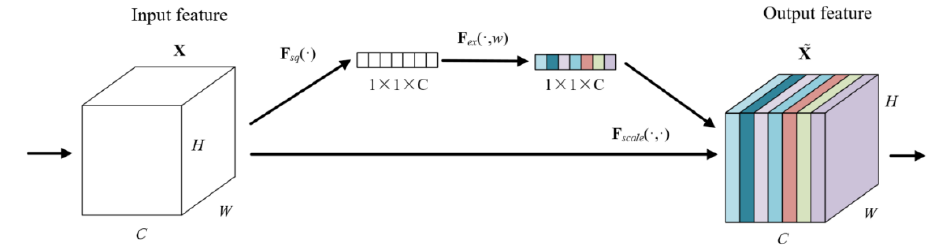
Figure 8. Channel attention mechanism model.